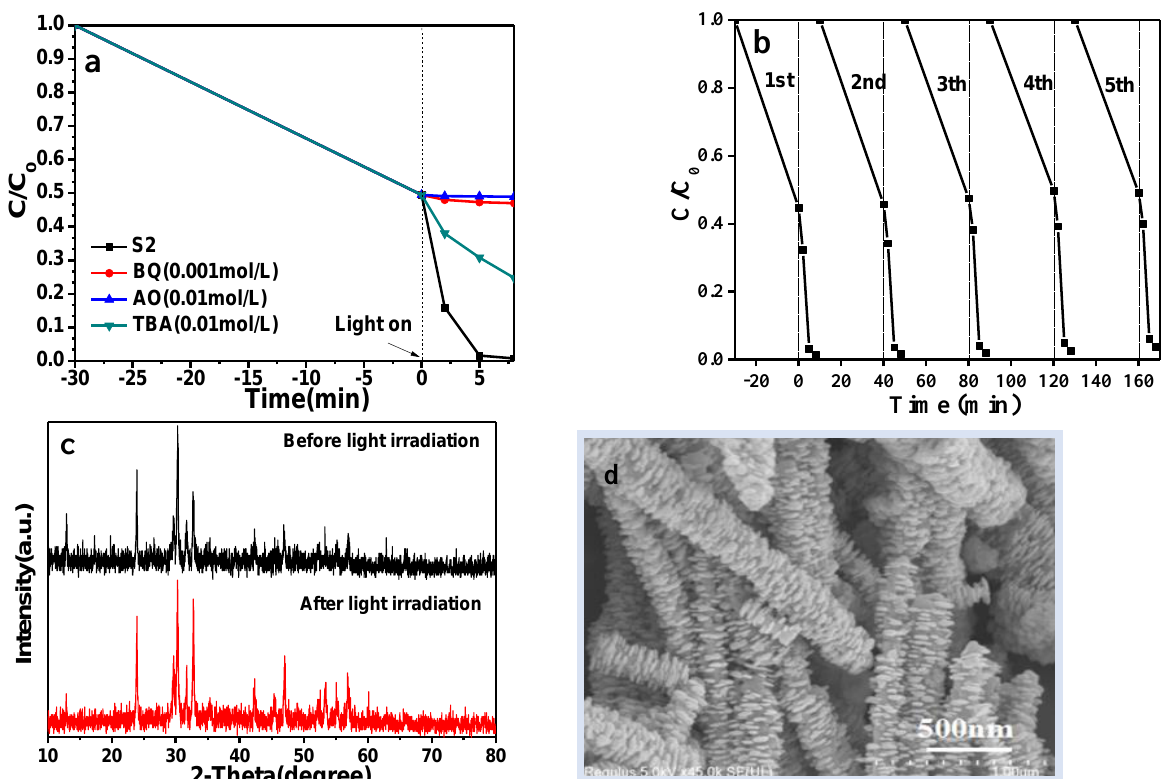
Figure 7. ( a ) The photo-degradation curves of Cr (VI) (30 mg/L) over S2 in the presence of different scavengers, ( b ) cycling times of the photocatalytic degradation of Cr(VI) (30 mg/L) under solar light irradiation, ( c ) the XRD pattern and ( d ) the SEM pattern of S2 after five repeated cycles.